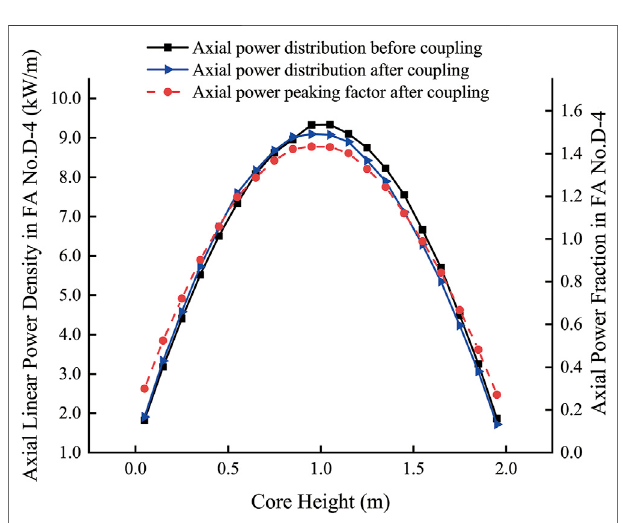
FIGURE9| Distributionofaxiallinepowerdensityandnormalizedpower density of D-4 assembly.